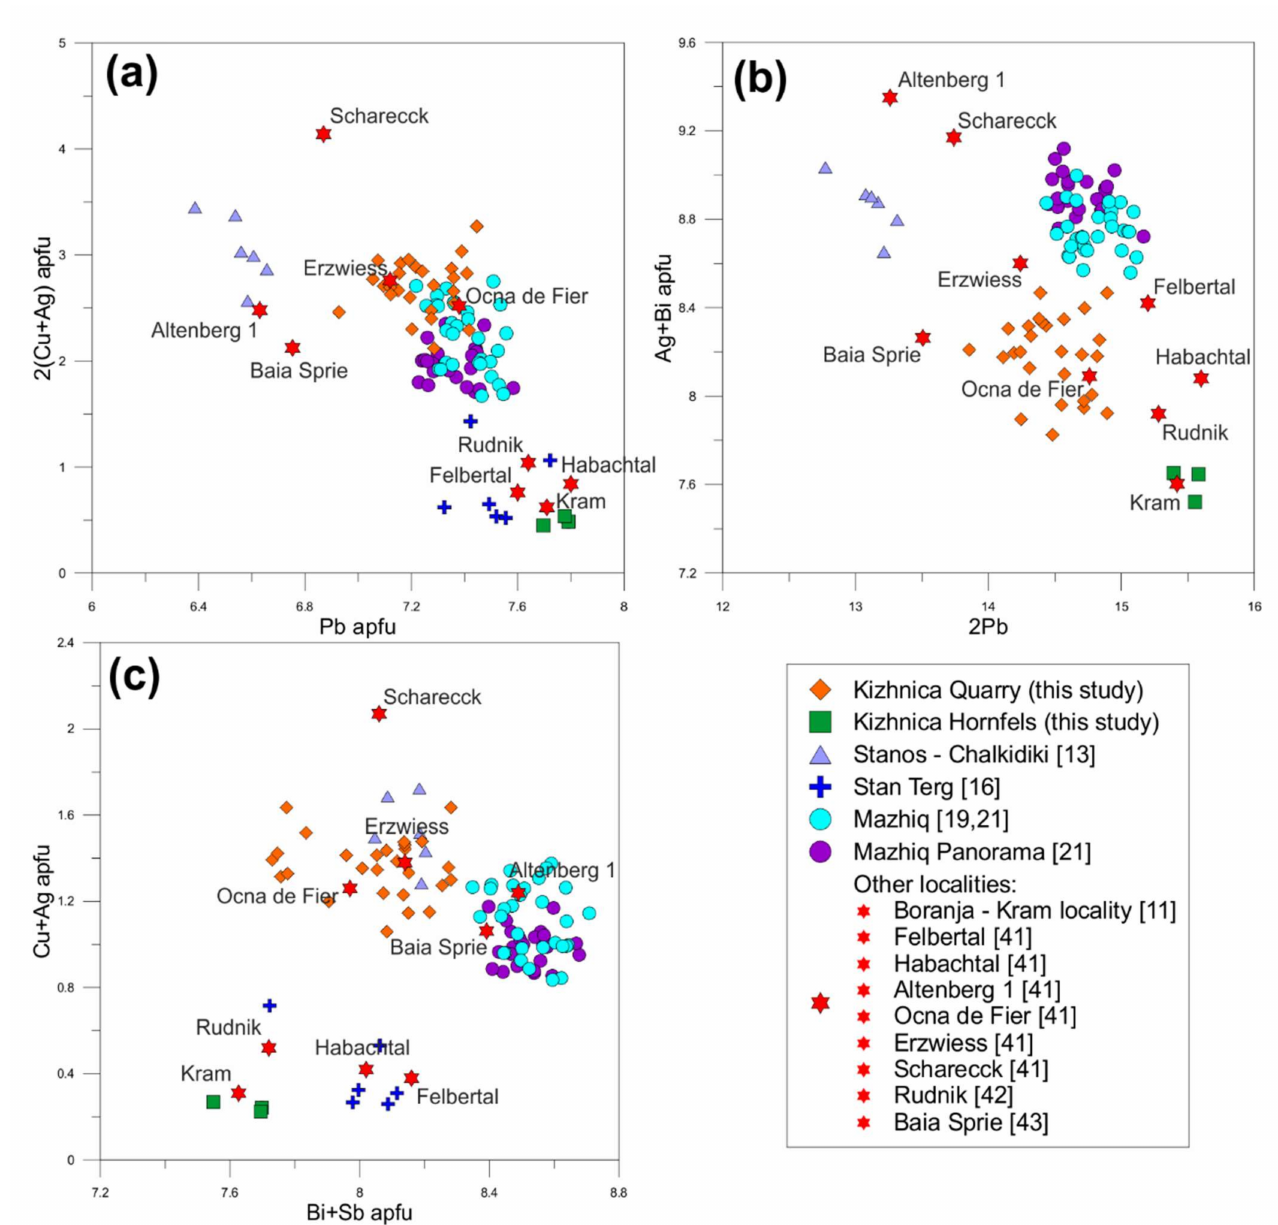
Figure 8. Binary plots showing the chemical composition of cosalite from the Kizhnica area and known locations of cosalite from the literature [11,13,15,16,19,21,41–43]: ( a ) 2(Cu + Ag) vs. Pb (apfu); ( b ) Ag + Bi vs. 2Pb (apfu); ( c ) Cu + Ag vs. Bi + Sb